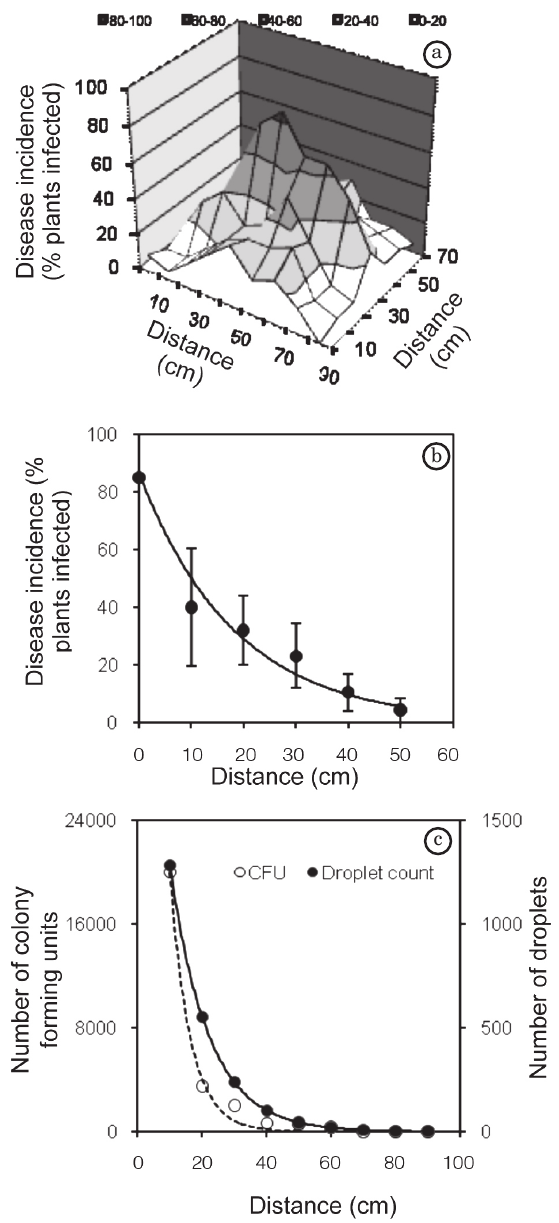
Figure 4. (a) Incidence of coriander blight (% plants infected in each 100 cm 2 ) in a stand of coriander seedlings 28 days after splash dispersal of Pseudomonas syringae pv. c oriandricola ( Psc ) from a central inoculum source; (b) relationship between incidence of coriander blight and distance from inoculum source (y=86.832e −0.0055x , R 2 =0.96); (c) Number of droplets and colony forming units (CFUs) of Psc splash dispersed on King’s B medium at different distances from a point source (droplets, y=97981e −0.1592x , R 2 =0.99, CFUs y=2983e −0.0843x , R 2 =0.99).